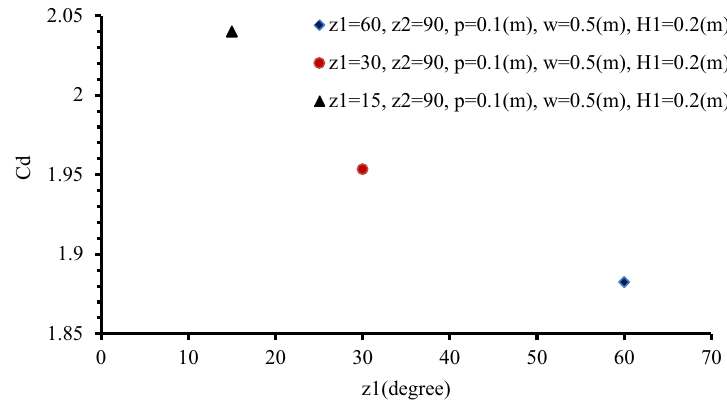
Fig. 12 Discharge coefficients for z lengths